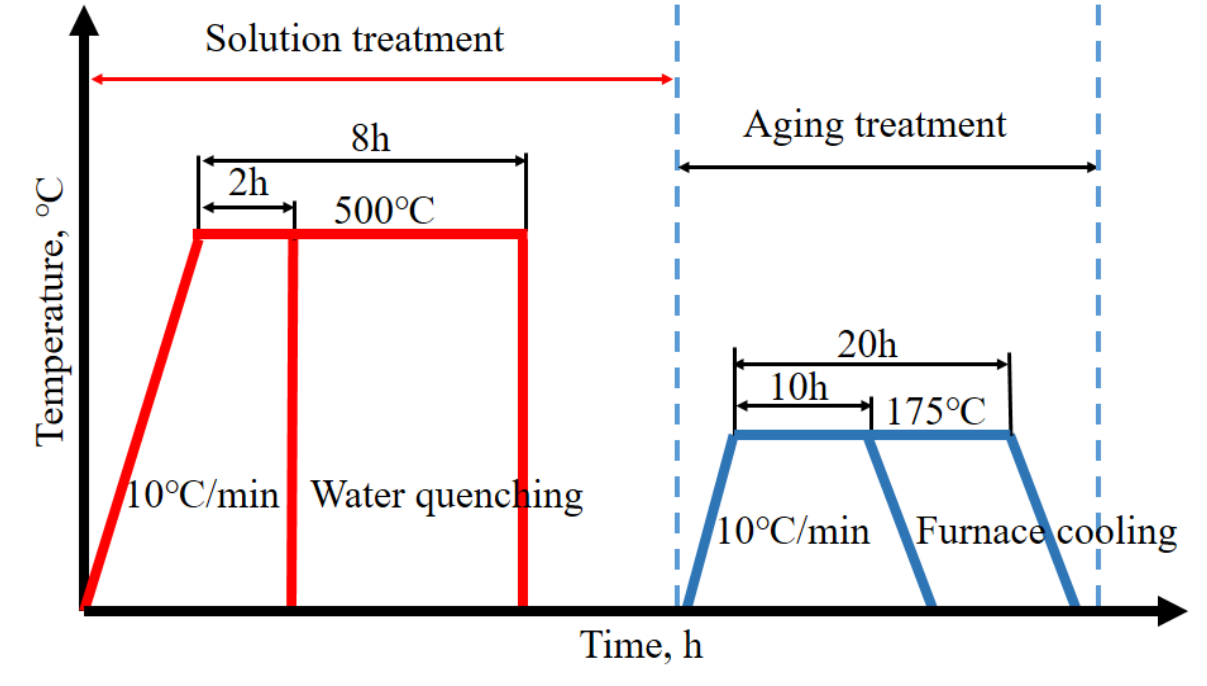
Figure 4. Roadmap for heat treatment.